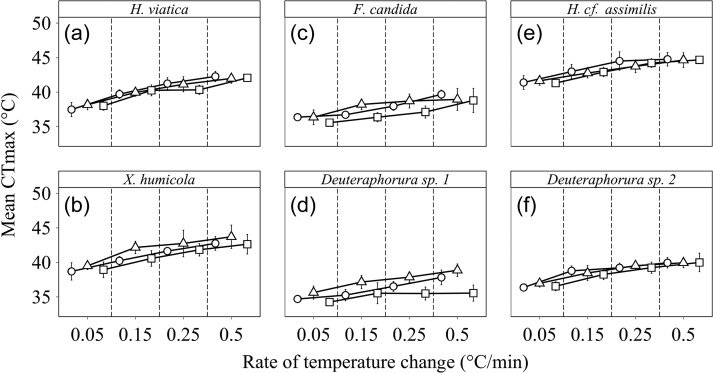
The effect of rate of temperature change and acclimation on the critical thermal
maximum (CTmax) of Hypogastrura viatica (polar; a),
Xenylla humicola (polar; b), Folsomia
candida (temperate; c), Deuteraphorura sp. 1
(temperate; d), Hypogastrura cf. assimilis
(sub-tropical; e) and Deuteraphorura sp. 2
(sub-tropical; f). Acclimation effects are: control (open circles, colony
temperature), high (open triangles, colony temperature +10°C) and low (open squares,
colony temperature −10°C). For each species, n = 26–31 at each rate
of temperature change for each acclimation treatment.